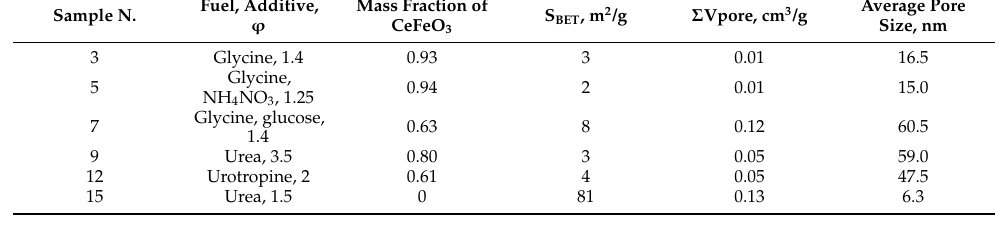
Table 3. Textural characteristics of the as-prepared samples produced by solution combustion synthesis using different fuels, additives, and fuel-to-oxidizer ratios ( ϕ ). Sample N.